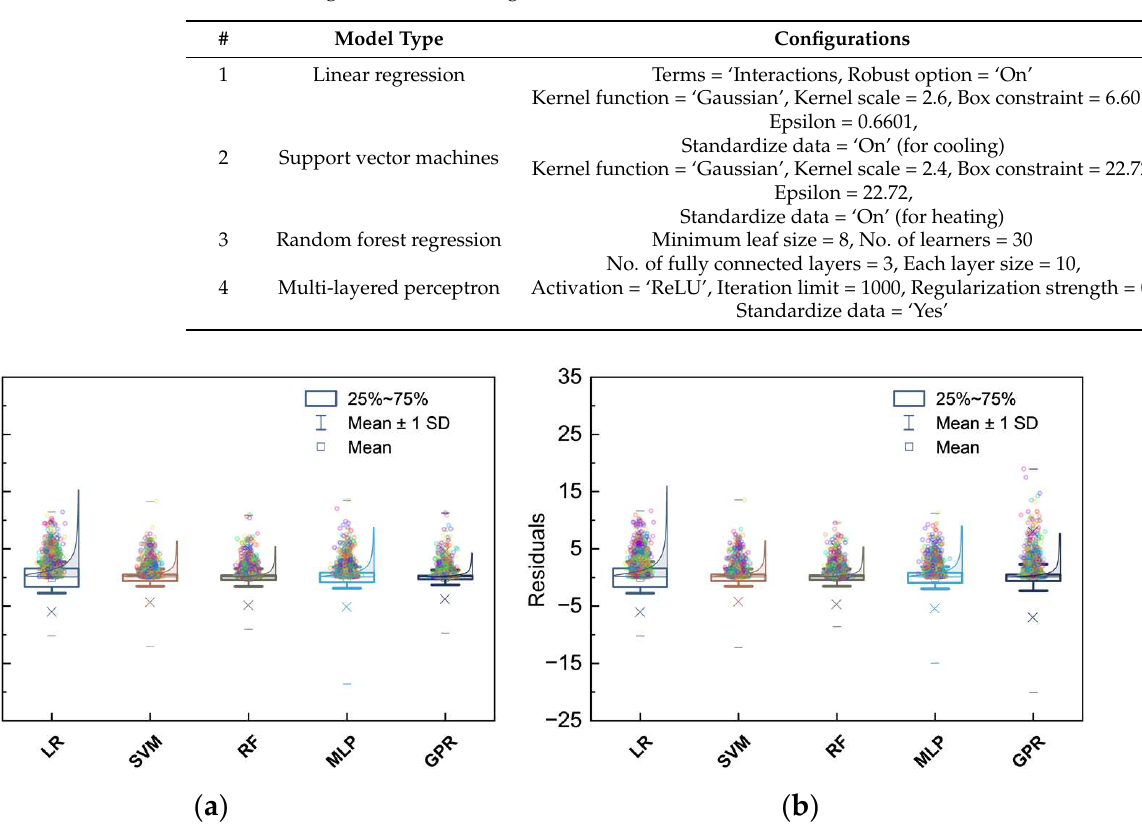
Table 5. Configurations of the regression models concerned.